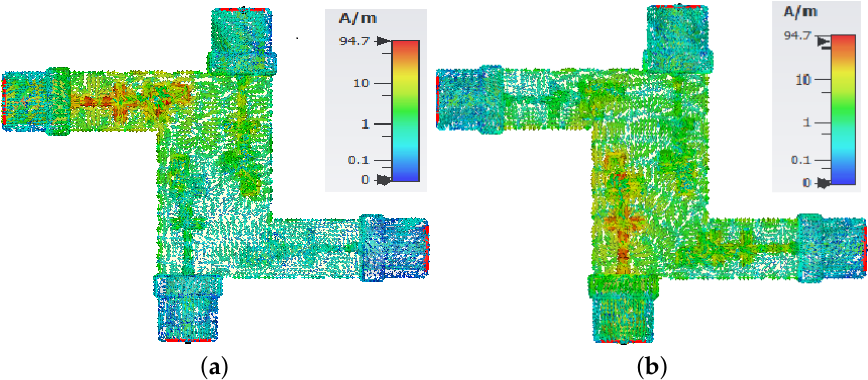
Figure 5. Surface current distribution of the MIMO antenna system for: ( a ) port-1; ( b ) port-2.